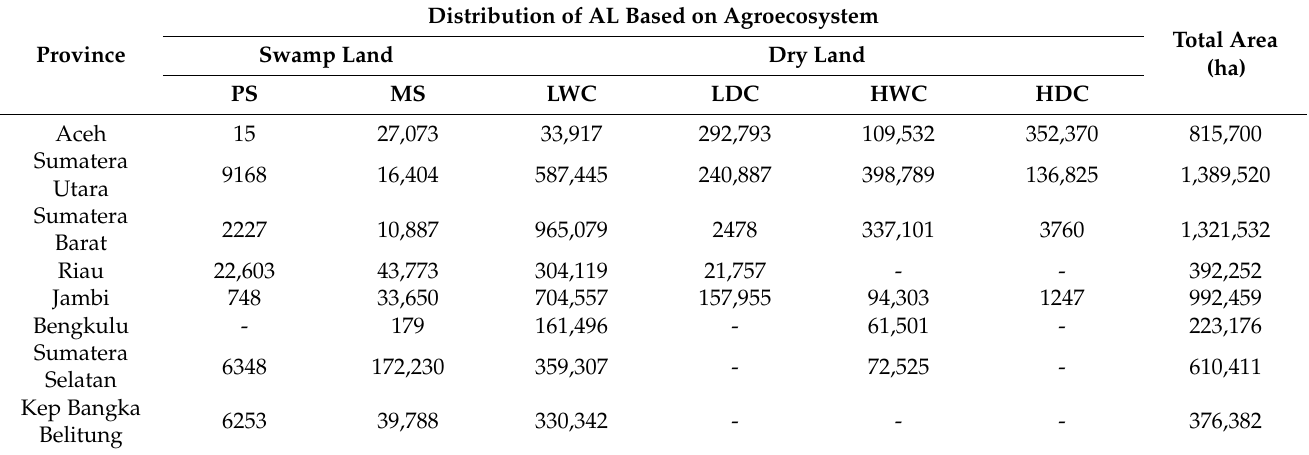
Table 2. Distribution of AL based on six agroecosystems in